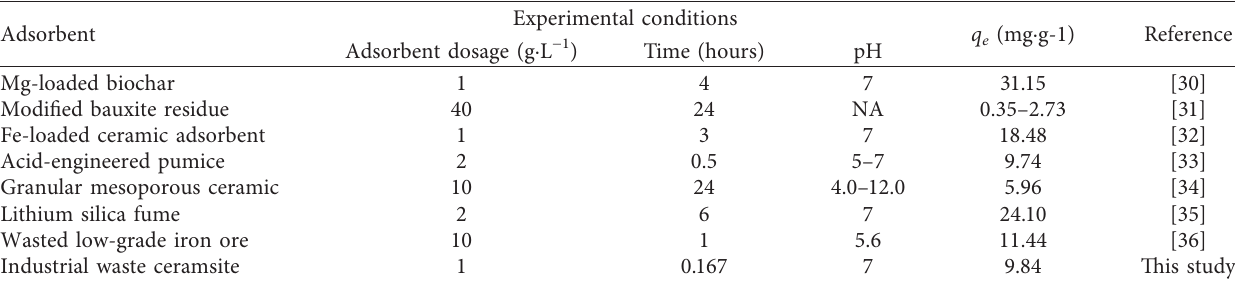
Figure 5: (a) Adsorption of phosphorus onto ceramsite; (b) Langmuir model fitting (pH � 7, t � 10min, adsorbent dosage � 1 g · L − 1 , and 120rpm). Table 4: Removal capacity comparison of different phosphorus adsorbents.